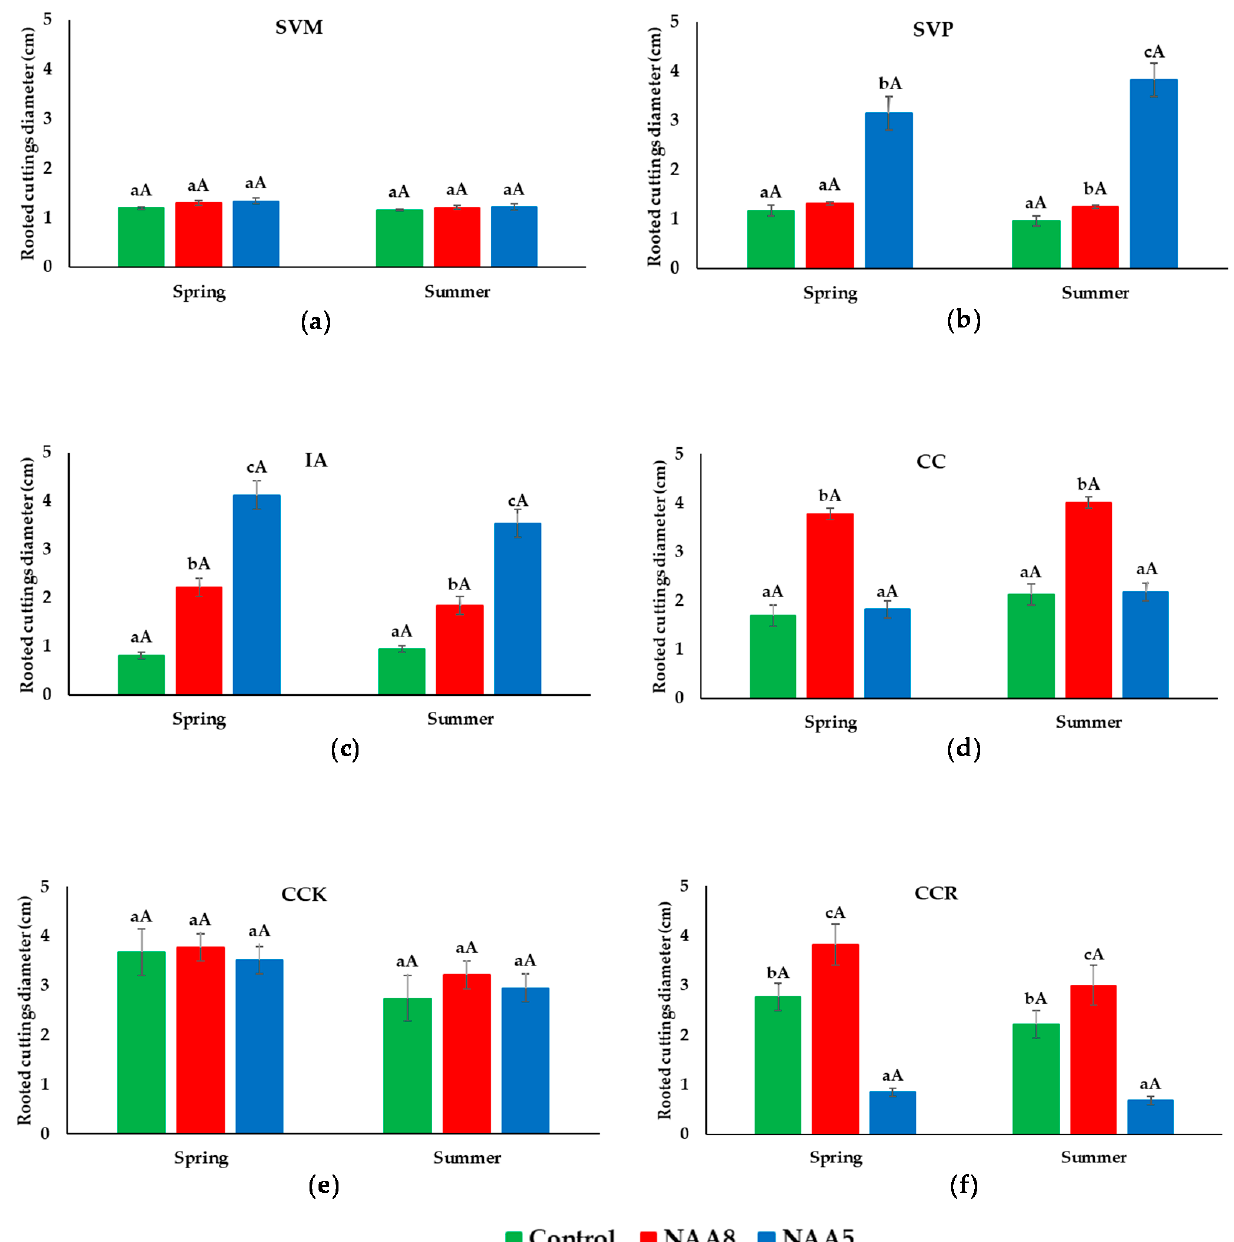
Figure 5. Effect of rooting stimulants (NAA8 and NAA5) on the diameter of rooted cuttings in the six selected ornamental shrubs: ( a ) Syringa vulgaris ‘Mme Lemoine’ (SVM); ( b ) Syringa vulgaris ‘President Grevy’ (SVP); ( c ) Ilex aquifolium (IA); ( d ) Cotinus coggygria (CC); ( e ) Cotinus coggygria ‘Kanari’ (CCK); ( f ) Cotinus coggygria ‘Royal Purple’ (CCR). Bars represent the means ± SE ( n = 30). Different lowercase letters above the bars indicate significant differences between the treatments, and different uppercase letters indicate the significant differences between the spring and summer propagated cuttings, according to Tukey’s test ( α = 0.05).